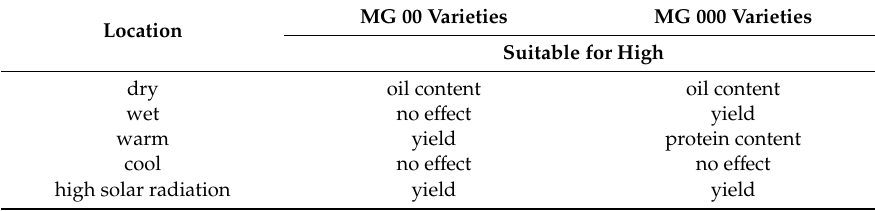
Table 7. Classification of soybean varieties according to their adaption to di ff erent locations in